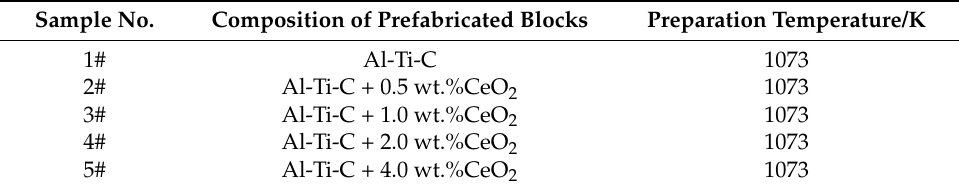
Table 2. The preparation parameters of different prefabricated